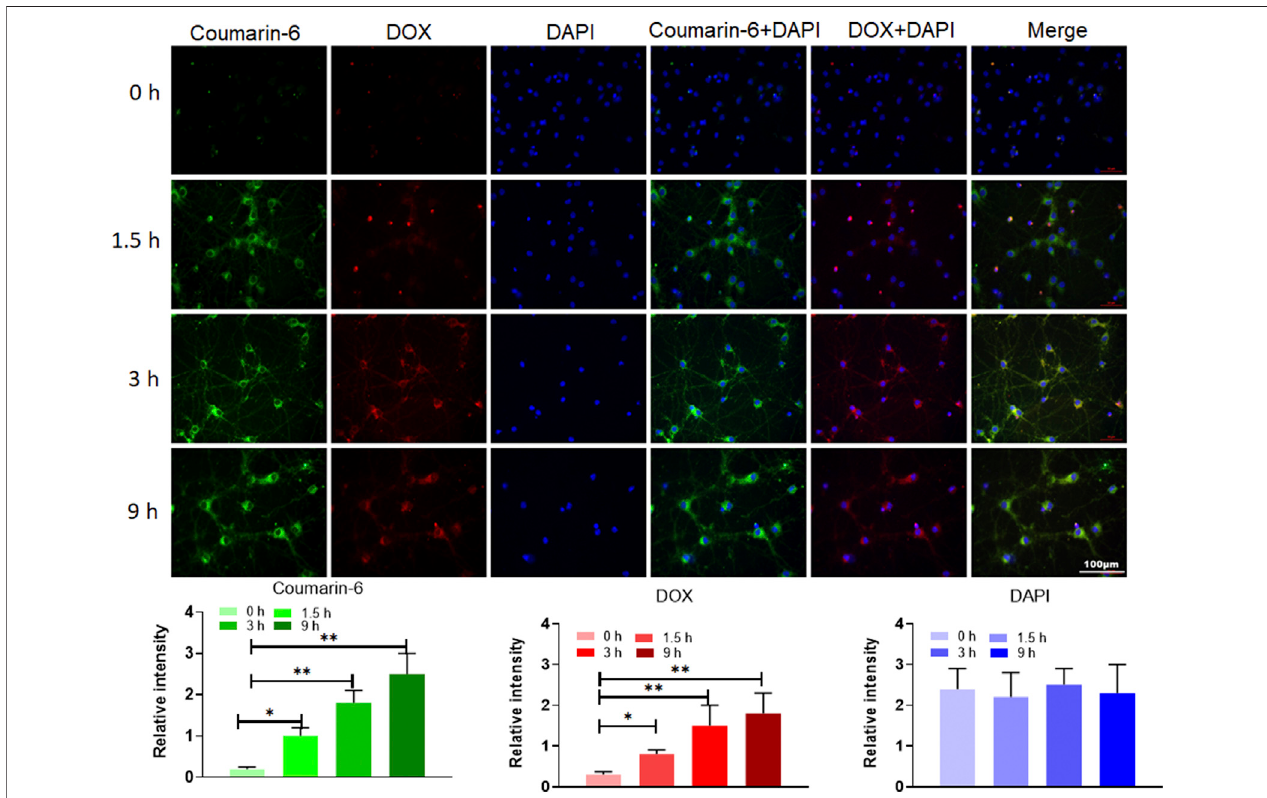
FIGURE 5 | The internalization assay of AUT NPs. Photographs in top are fl uorescent images of cell in different time points. Histograms in bottom are quantitative analysis of fl uorescent intensities in different time points. The ** p < 0.01; The * p < 0.05.